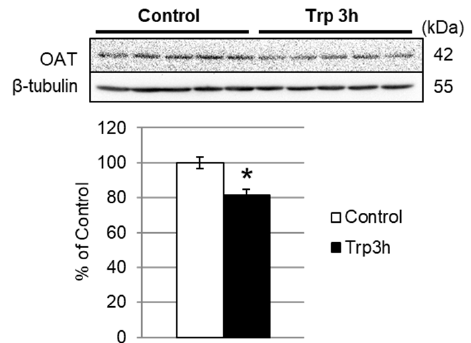
Figure 2. Decreased OAT protein expression in the liver after oral administration of Trp. Liver lysates were immunoblotted for OAT. The bar graph shows OAT expression normalized with β -tubulin expression. Data are expressed means ± SEM, n = 5. (*) Indicates significant di ff erence between control versus Trp 3h ( p < 0.05). Nutrients 2020 , 12 , x FOR PEER REVIEW